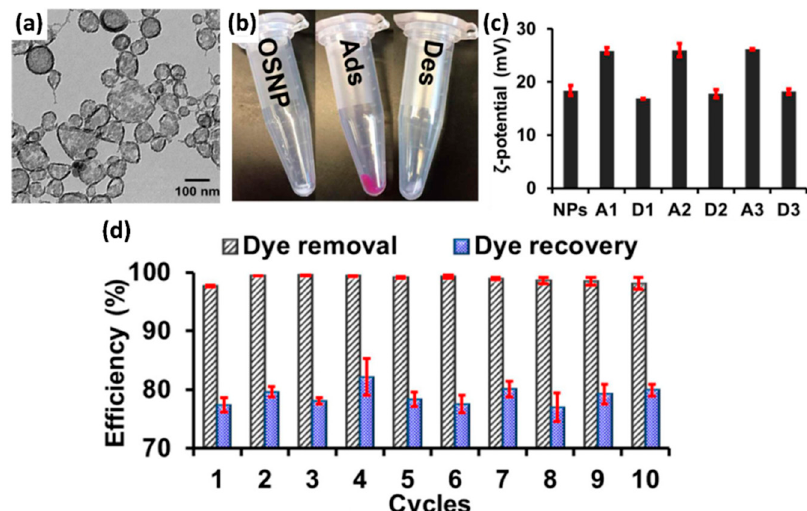
Figure 7. ( a ) TEM image for OSNPs. ( b ) Color change of OSNP after adsorption (Ads.) and desorption (Des.) of phenol red (PR). ( c ) Zeta potential of original OSNP and after three cycles of dye adsorption (A) / desorption (D). ( d ) PR adsorption / desorption recycle test for OSNP (reproduced with permission from [49]. Copyright American Chemical Society, 2017).